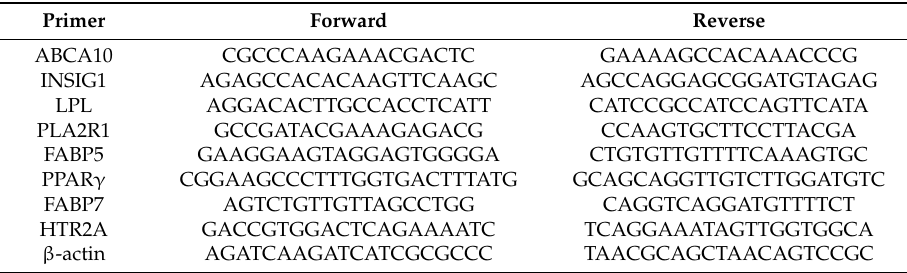
Table 4. Reaction mixtures were incubated for pre-denaturation at 95 ◦ C for 5 min, followed by 40 PCR cycles: 10 s at 95 ◦ C, 15 s, for 60 ◦ C and 20 s, for 72 ◦ C. Relative expression was calculated using the ∆∆ C t 2 − method. Table 4. Primer sequences for target